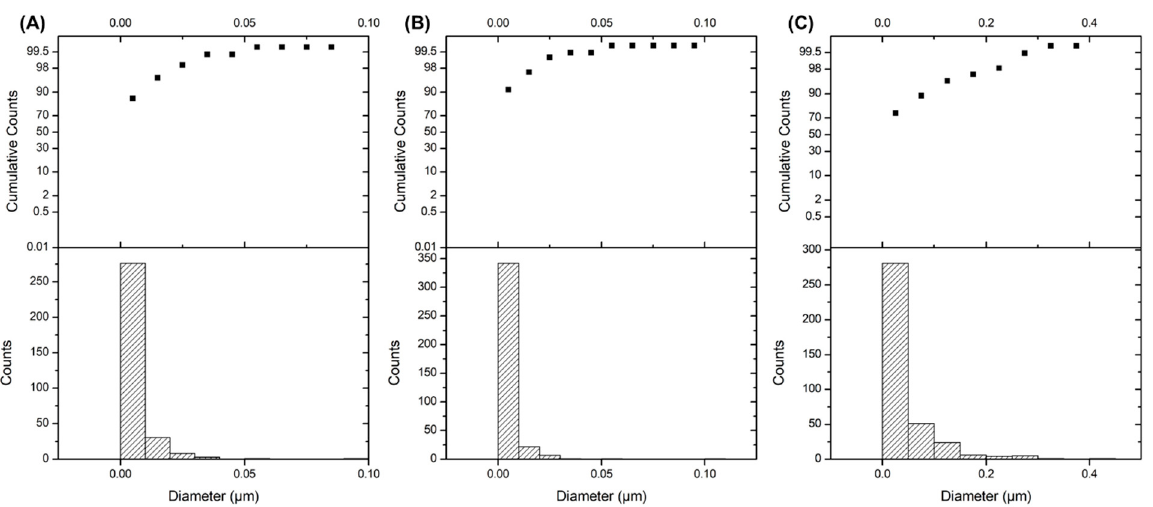
Figure 6. Diameter and distribution of ( A ) 30% Ag, ( B ) 40% Ag and ( C ) 50% Ag particles on the Si films, as analysed via ImageJ software. Table 3. The average Ag particle diameter for each sample.